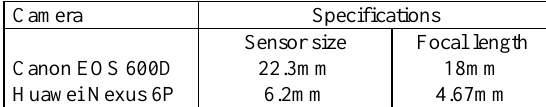
Table 1. Utilised DSLR and mobile phone cameras.